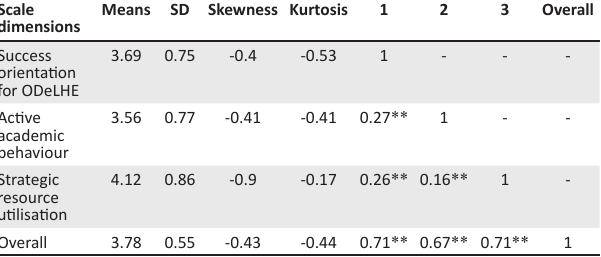
TABLE 5: Adult learner self-directedness scale: Means, standard deviations, skewness, kurtosis and Pearson correlations. Scale Means SD Skewness dimensions